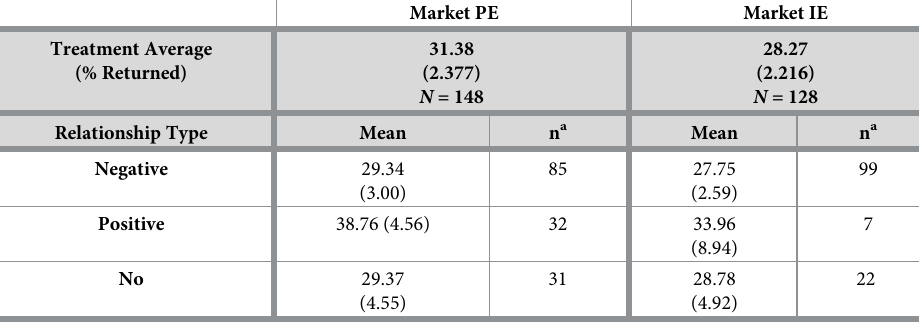
Table 2. Summary of Player 2 transfers in Markets PE and IE by relationship type.